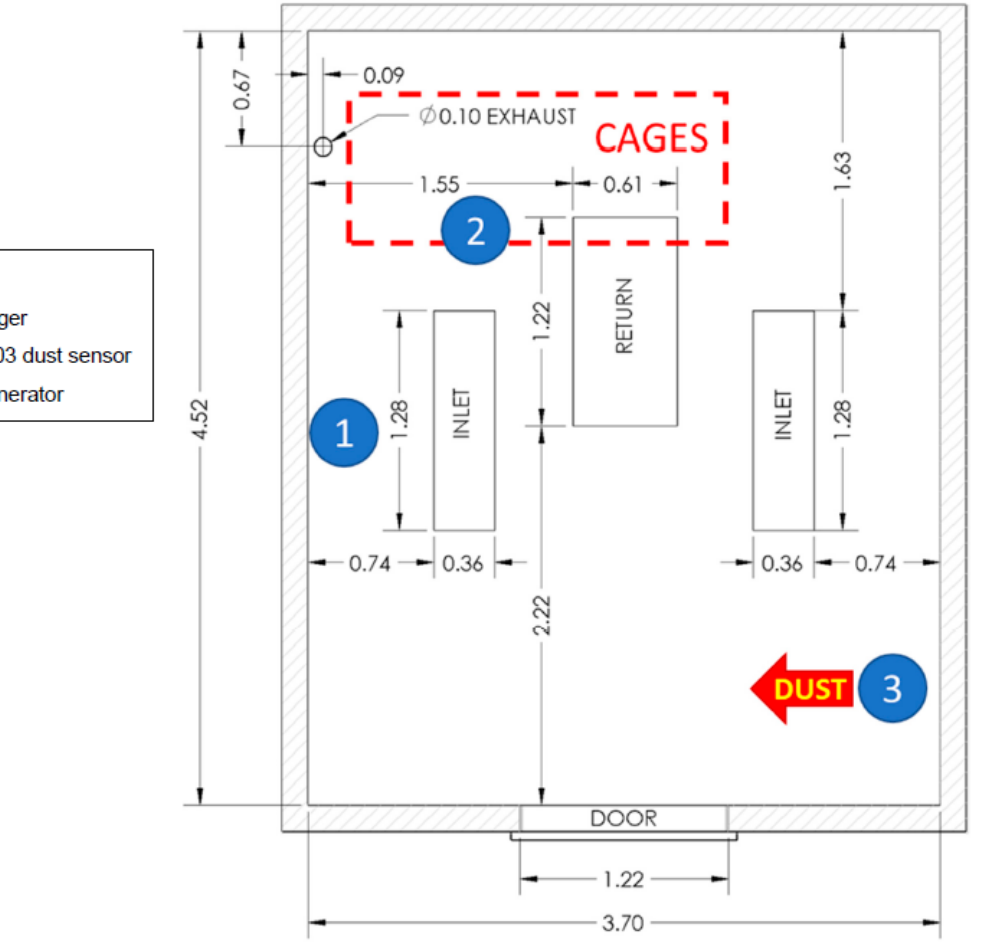
Figure 11. Plan view of controlled environment TEST chamber (all dimensions shown in meters).